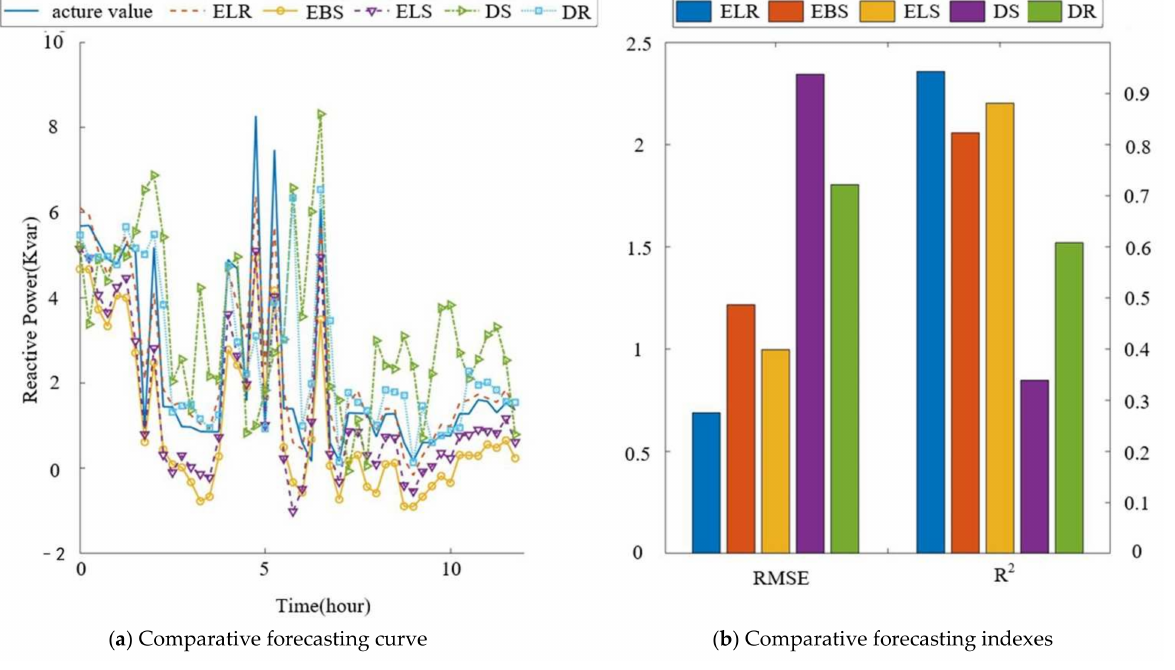
Figure 11. Results of four groups of hybrids forecasting